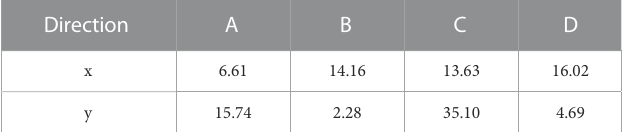
TABLE 8 Reduction of residual stress with ultrasonic frequency from 0 kHz to 20 kHz (%).